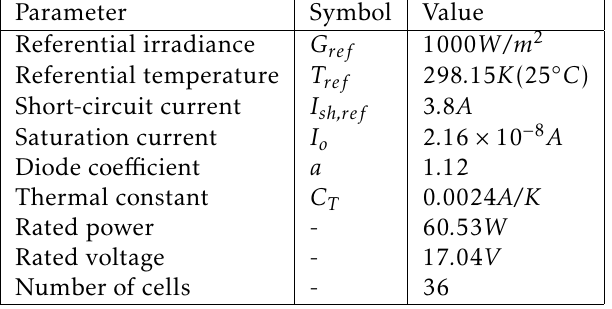
, placed on each 1 G 2 G 3 ]